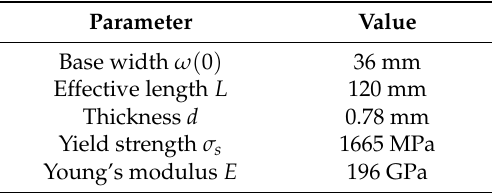
Table 4. The actual design parameter of the geometric anti-spring